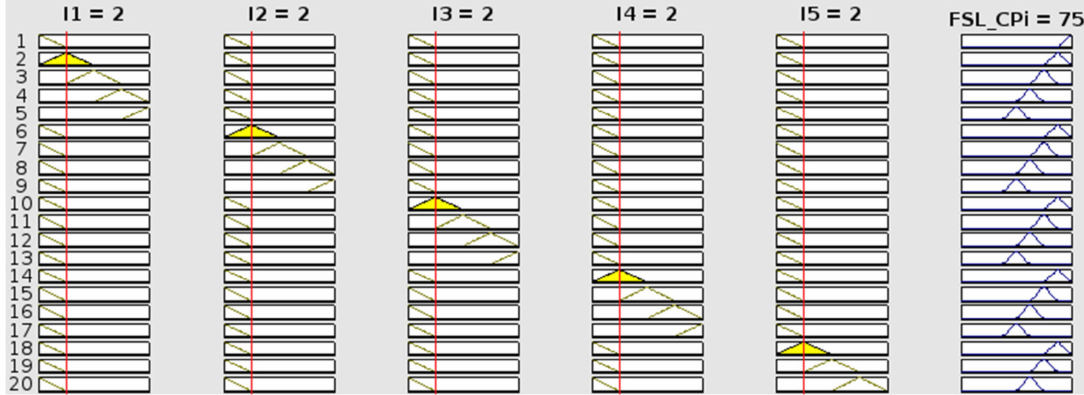
Figure 5. Fuzzy logic reason